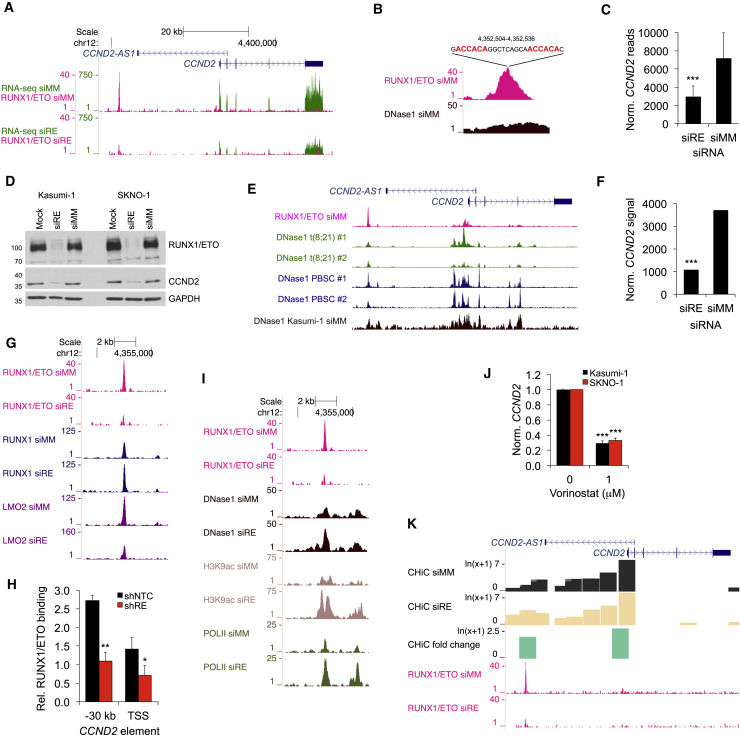
RUNX1/ETO Controls CCND2 Expression via an Upstream Regulatory Element(A) University of California, Santa Cruz (UCSC) genome browser screenshot displaying changes in transcript levels (green) based on RNA sequencing (RNA-seq) and RUNX1/ETO binding (pink) based on ChIP-seq at the CCND2 locus in Kasumi-1 cells. siRE, RUNX1/ETO small interfering RNA (siRNA); siMM, mismatch control siRNA. Scale and nucleotide positions are indicated at the top.(B) Screenshot of RUNX1/ETO binding and DNase1 hypersensitive sites (DNase1) at the −30 kb region of CCND2 in Kasumi-1 cells treated with siMM. The location and sequence are shown on top with the RUNX1 consensus sites indicated in red.(C) Change in CCND2 transcript levels between Kasumi-1 cells treated with siMM and siRE, as determined by RNA-seq. ∗∗∗p < 0.001 compared with siMM.(D) Immunoblots of CCND2 protein levels in Kasumi-1 and SKNO-1 cells following RUNX1/ETO knockdown. Mock, electroporated without siRNA.(E) Chromatin accessibility at CCND2 for two t(8;21) AML patients (t(8;21) #1 and #2), normal CD34+ PBSCs from two donors (PBSC #1 and #2) and Kasumi-1 cells as judged by DHS-seq. Top panel, RUNX1/ETO binding by ChIP-seq.(F) CCND2 transcript levels in primary AML (patient sample L852) with (siRE) and without (siMM) RUNX1/ETO knockdown as analyzed by Illumina bead arrays with probe ILMN_2067656. ∗∗∗p < 0.001 (Illumina custom false discovery rate [FDR]) compared with siMM.(G) Effect of RUNX1/ETO knockdown on transcription factor binding at the CCND2 locus in Kasumi-1 cells.(H) Assessment of RUNX1/ETO in control (shNTC) or RUNX1/ETO knockdown (shRE) Kasumi-1 cells at the −30 kb element of CCND2 by manual ChIP. n = 3; mean ± SD; ∗p < 0.05; ∗∗p < 0.01 compared with shNTC.(I and J) (I) Assessment of epigenetic changes by ChIP-seq and DHS-seq in chromatin structure, histone K9 acetylation, and RNA Pol II occupation at the −30 kb element upon RUNX1/ETO knockdown (siRE) in comparison with siMM in Kasumi-1 cells. (J) Impact of the HDAC inhibitor vorinostat on CCND2 RNA expression normalized to GAPDH (norm. CCND2) in t(8;21) AML cell lines. n = 3; mean ± SD; ∗∗∗p < 0.001 compared with shNTC.(K) Genome browser screenshot of promoter capture CHiC in Kasumi-1 cells visualizing the impact of RUNX1/ETO depletion on the interaction of the −30 kb element with the CCND2 TSS. Control siRNA treatment, CHiC siMM; RUNX1/ETO knockdown, CHiC siRE. CHiC fold change, fold difference in interaction between RUNX1/ETO knockdown and control.See also Figure S2.